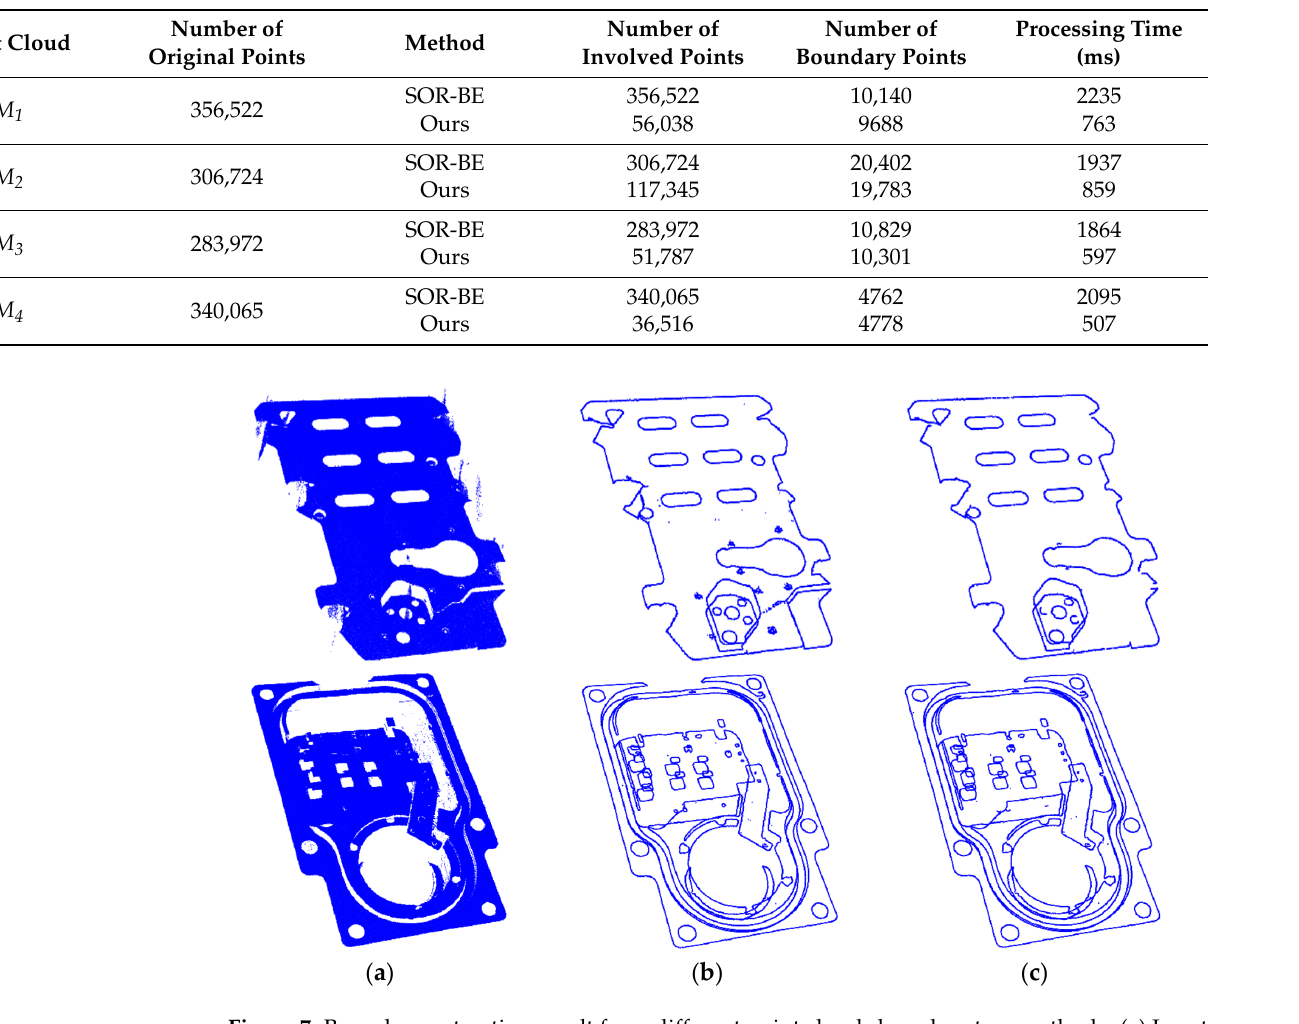
Table 1. Comparison between boundary extraction results of two methods.